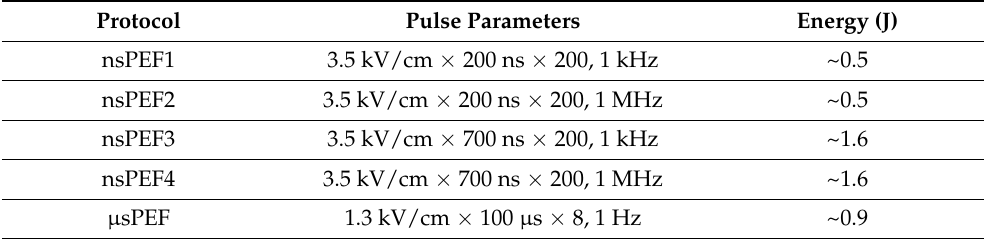
Table 1. Electroporation protocols employed in the study